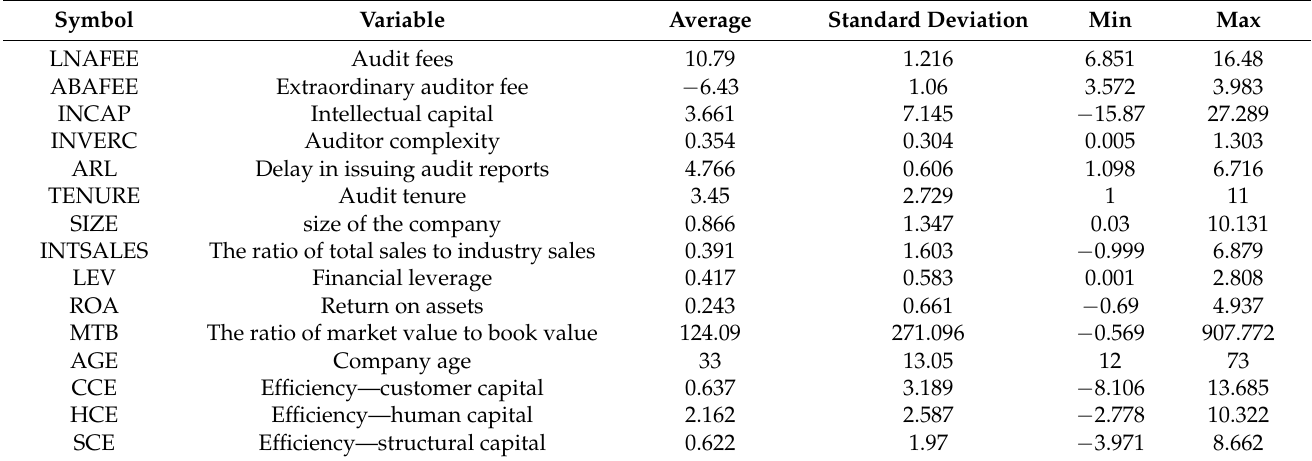
Table 2. The Descriptive statistics.